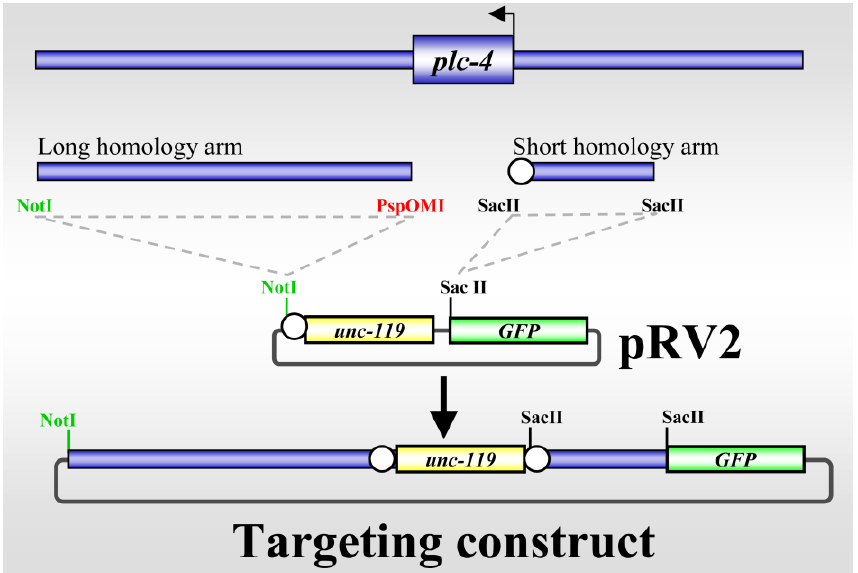
FIGURE 4. A dual-selection vector for gene targeting in C. elegans . pRV2 contains two selection markers, unc-119p::unc-119 (yellow box) and myo-2p::GFP (green box) in pGEM-5Z. Flanking the left site of unc-119p::unc-119, there is an FRT sequence and a Not I restriction site. Between both markers, a Sac II restriction site is present. To produce a targeting vector, a long homology sequence, corresponding to the region downstream of the stop codon of the target gene, is introduced into the Not I site. A short arm, homologous to the sequence upstream of the start codon of plc-4 , is amplified by PCR together with an FRT site provided in the left primer and cloned within the Sac II site. Blue bars show genomic DNA sequences homologous to the region flanking the gene to be targeted. The plc-4 locus is shown at the top of the figure (not to scale). Empty circles represent FRT sequences. The thin grey bar represents the pGEM-5Z